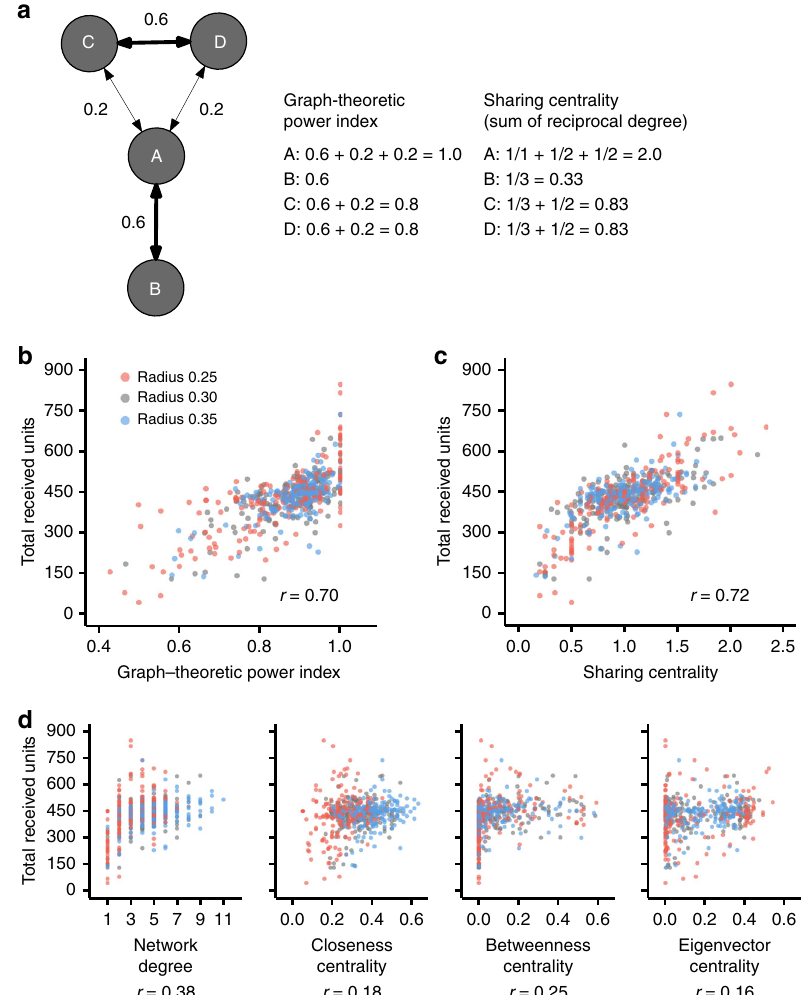
Fig. 6 Power index and sharing centrality are highly correlated with the economic bene fi t in a sharing network. a Graph-theoretic power index (GPI) captures the probability the focal node will be engaged in a successful mutual selection with one of his or her alters. This in turn, gives the node a structural advantage in bargaining in strategic interactions. The easiest way to understand how the geodesic position bene fi ts a node is the following simple scenario. Suppose node A randomly selects one of her neighbors (say node C) in order to allocate all its resource; then if C has also selected node A as its unique collaborator, asymmetric and fully reciprocal relationship can be established and both node C and A will stop seeking collaborators. Otherwise, node A can proceed and select another node as a potential collaborator. This iterative process continues until a mutual selection is achieved for every possible pair of nodes. It is easy to see that each dyad has a different probability of mutual selection throughout this iterative process. Namely, the probability of mutual selection (by concurrent nomination in an repetitive process) is 0.6 for the edges a , b and c , d , and 0.2 for a – c and a – d . In total, this means that node A can fi nd a full reciprocator with probability 1, while for node B the probability is 0.6 and for nodes C and D it is 0.8. Sharing centrality is the sum of reciprocal network degree among alters. The centrality approximates the structural advantage, which GPI represents, but using only local topology information. b – d Dots indicate several measures of network centrality for each subject and his or her total received units at the end of game (out of N = 600 subjects who participated). Dot color indicates the network ’ s connection radii; red for radius = 0.25, gray for radius = 0.30, and blue for radius = 0.35. GPI and sharing centrality show clear correlation with their economic bene fi t from a sharing game ( b , c ). This correlation is higher than all the other centrality measures ( d ). The “ r ” values indicate Pearson correlation coef fi cients ( P < 0.01 for all the correlation coef fi